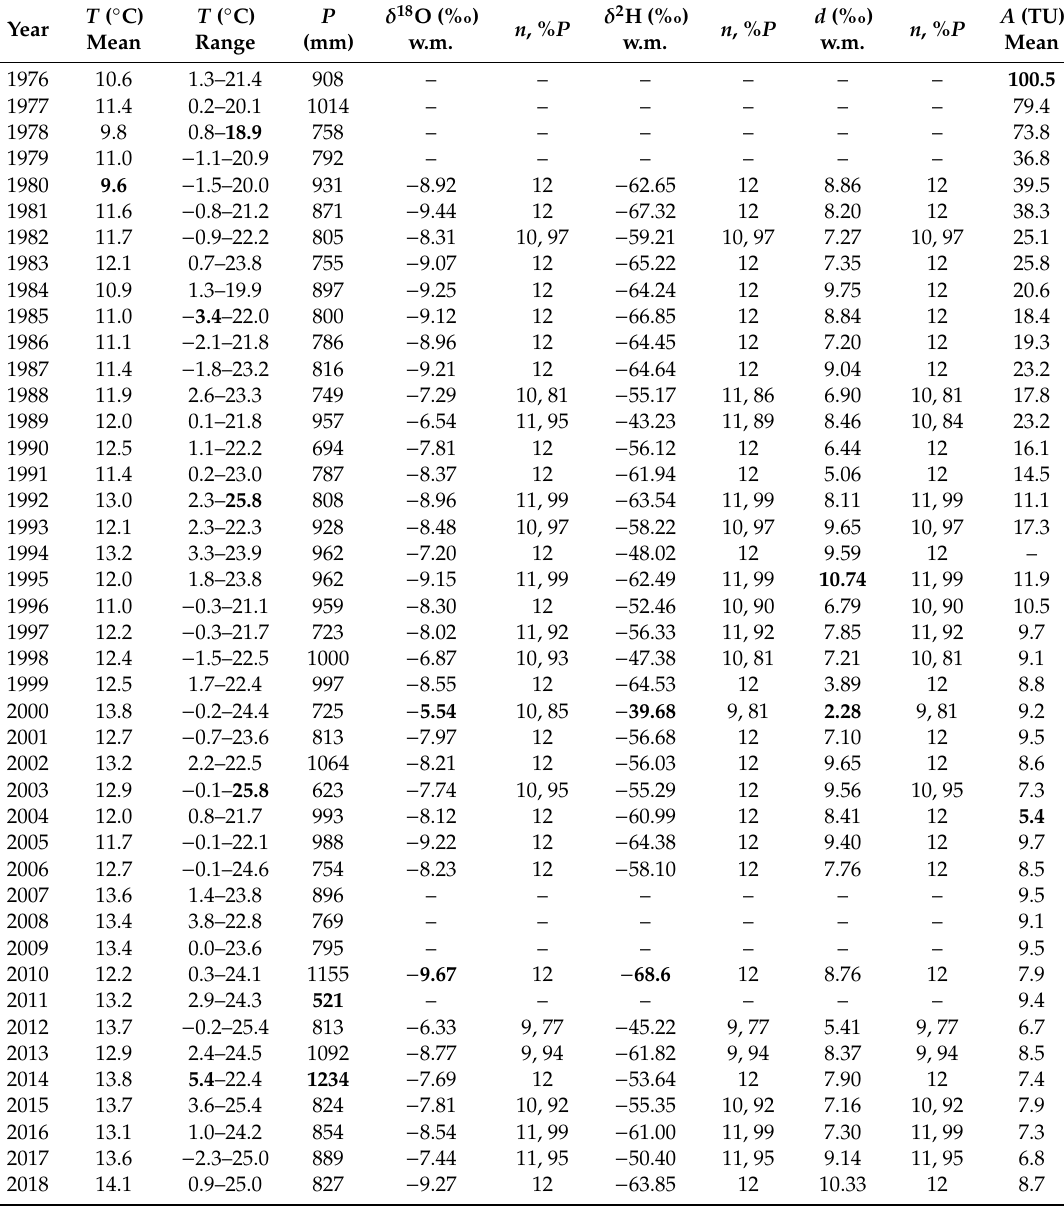
Table 1. Mean annual temperature T , ranges of monthly temperatures within a year, annual precipitation amount P, weighted mean (w.m.) annual δ 18 O, δ 2 H, d -excess ( d ), and the mean annual tritium activity concentration A in precipitation at Zagreb, 1976–2018. Here, n : number of monthly datapoints; % P : percentage of precipitation if di ff erent from 100%, comprised by δ 18 O, δ 2 H, and d -excess data; TU: tritium unit. Bold font: the lowest and highest values in a